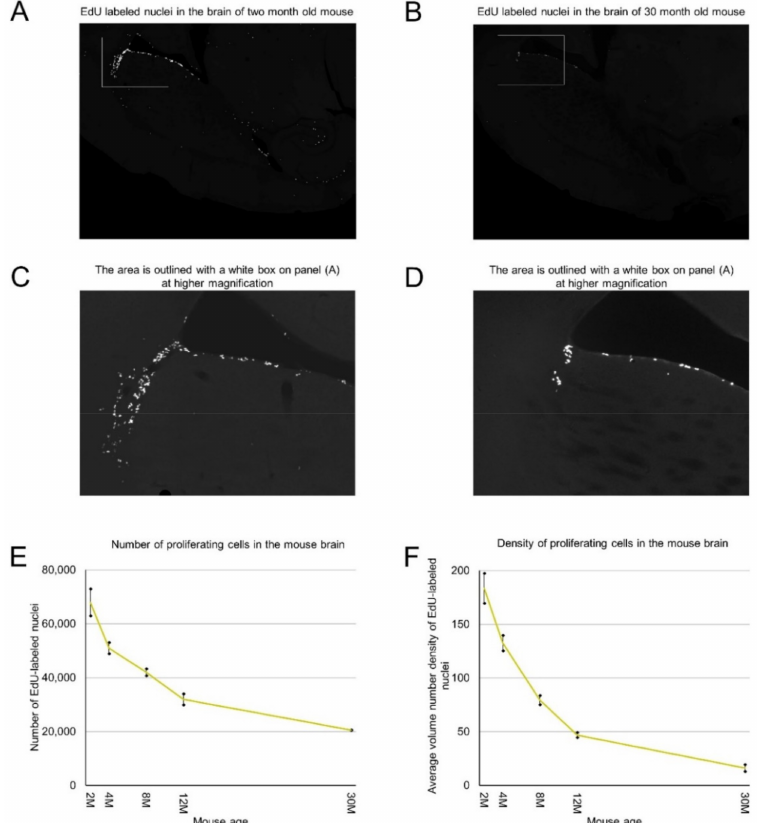
Figure 1. Age-related decrease in the number and density of proliferating cells in the mouse brain. ( A – D ) Proliferating cells are distributed in the mouse brain unevenly. 2 months ( A ) and 30 months ( B ) old mice. ( C ) The area outlined with a white box on panel ( A ) is shown at high magnification. ( D ) The area outlined with a white box on panel ( B ) is shown at high magnification. ( E ) The number of detected proliferating cells in the mouse brain decreases with mouse age. The means are significantly heterogeneous (one-way analysis of variance (ANOVA), F4, 5 = 316, p = 3.6 × 10 − 6 ). Error bars show standard deviation. ( F ) The average volume number density of proliferating cells in the mouse brain decreases with mouse age. The means are significantly heterogeneous (one-way ANOVA, F4, 5 = 160, p = 31.8 × 10 − 5 ). Error bars show standard